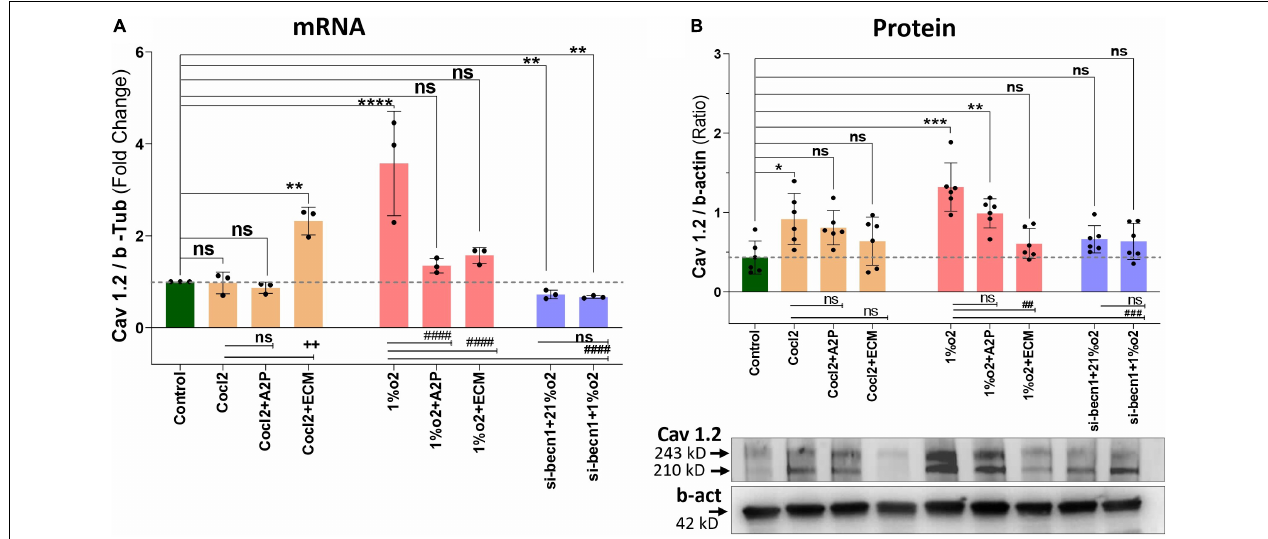
FIGURE 3 | Hypoxia and Cocl2 exposure modifies the H9c2 cells Cav1.2 (CACNA1C) expression both at mRNA and protein level. (A) Cav1.2, mRNA expression levels, (B) Cav1.2 Protein expression levels and representative western blots. Compared to Controls Hypoxia increased the Cav1.2 expression at mRNA (**** p < 0.0001) and Protein level (*** p < 0.001). In addition, Cav1.2 mRNA levels are increased in Cocl2 + ECM (** p < 0.002) exposed cells. Compared to Hypoxia (1%O2), cells exposed to 1%O2 + A2P ( #### p < 0.0001), 1%O2 + ECM ( #### p < 0.0001) and in Beclin-1 inhibition cells grown under Hypoxia expressed significant decrease in Cav1.2 mRNA ( #### p < 0.0001) and Protein ( ### p < 0.001) expression levels. Data represents, n = 3 (mRNA) and n = 5 (Protein) independent samples/group. Bars are mean ± S.D. Symbols * , + , #, and (cid:54)= denotes significant, “ns” represents not significant by two-way ANOVA- multiple comparisons